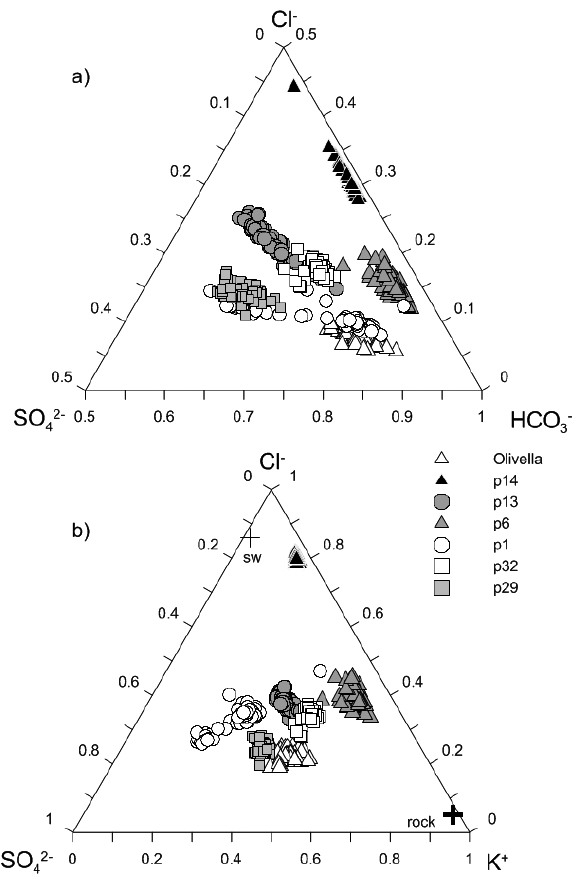
Figure 3. a) Cl − -SO 42− -HCO 3− triangular diagram. b) Cl − -SO 42− -K + tri- angular diagram. The average composition of lava and scorias from Belkin et al. [1998] and the point representative of seawater are plot- ted for comparison. Concentrations are expressed in units of mg·l −1 .